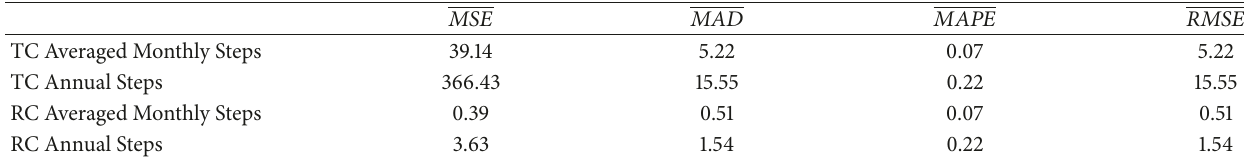
Table 10: Average for main measures of error for MR-OUP after 1000 MC simulations 2013.